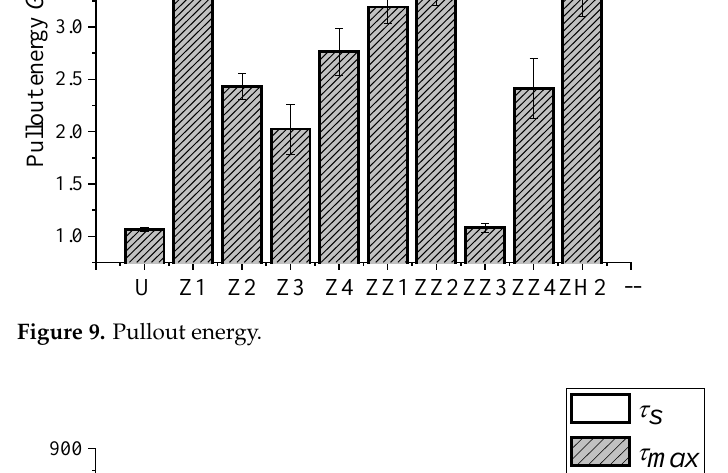
Figure 9. Pullout energy.